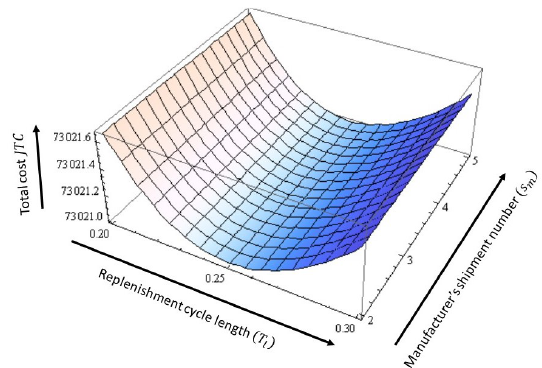
Figure 3. Total cost (JTC) for the CLSC versus manufacturer’s shipment number ( s m ) and replenishment cycle length ( T l ) when s l and β are fixed, s m and T l are variable.